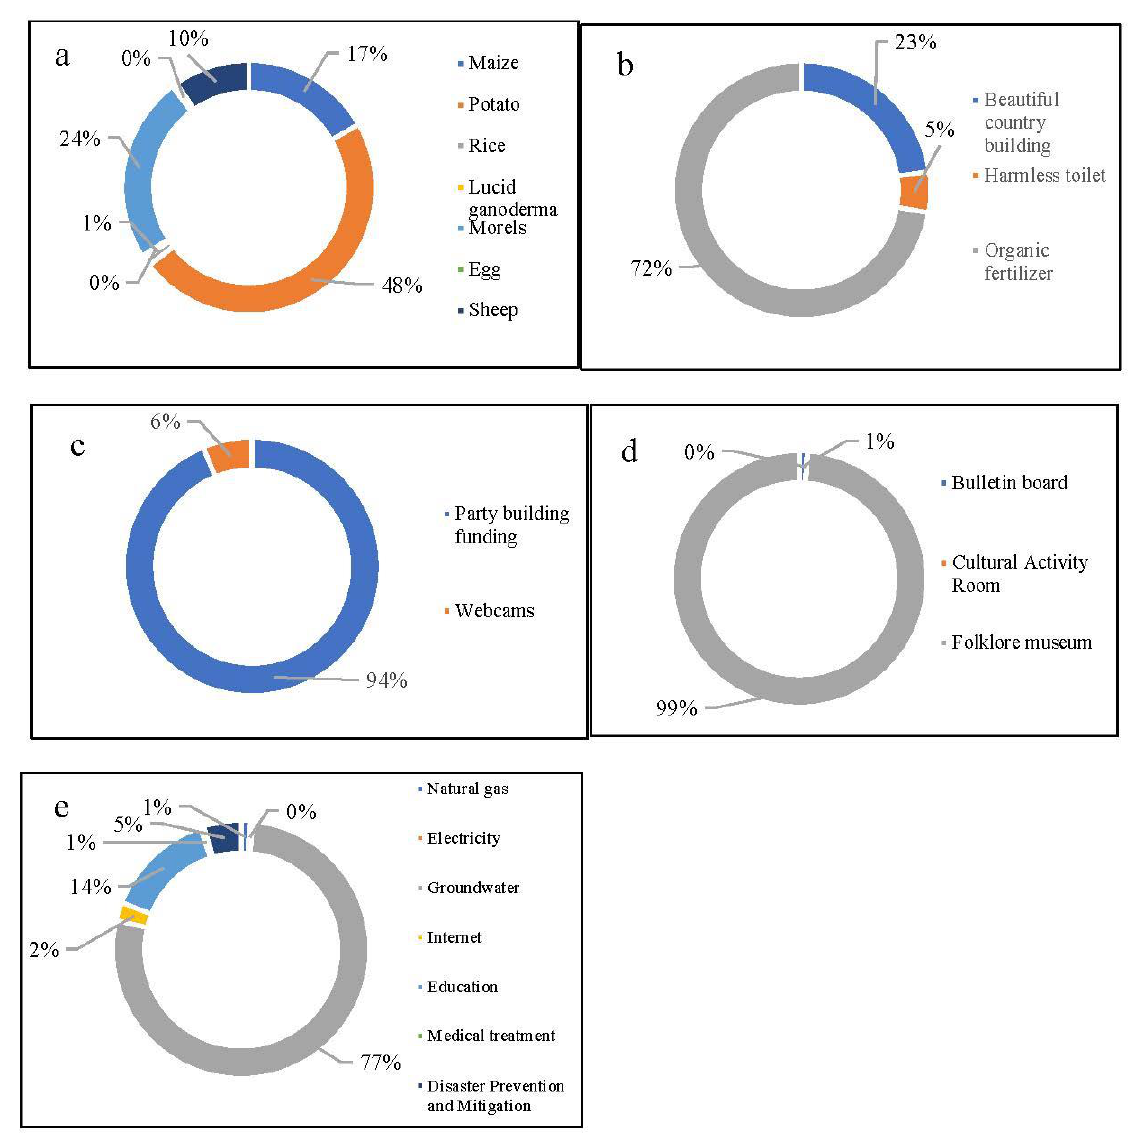
Figure 5. Structural analysis of rural revitalization of Chehe Village. Note: the subfigures is the proportion of items included in each part, ( a ) is the industrial economy; ( b ) is the ecologically livable; ( c ) is the rural governance; ( d ) is the social civilization; ( e ) is the rich life.